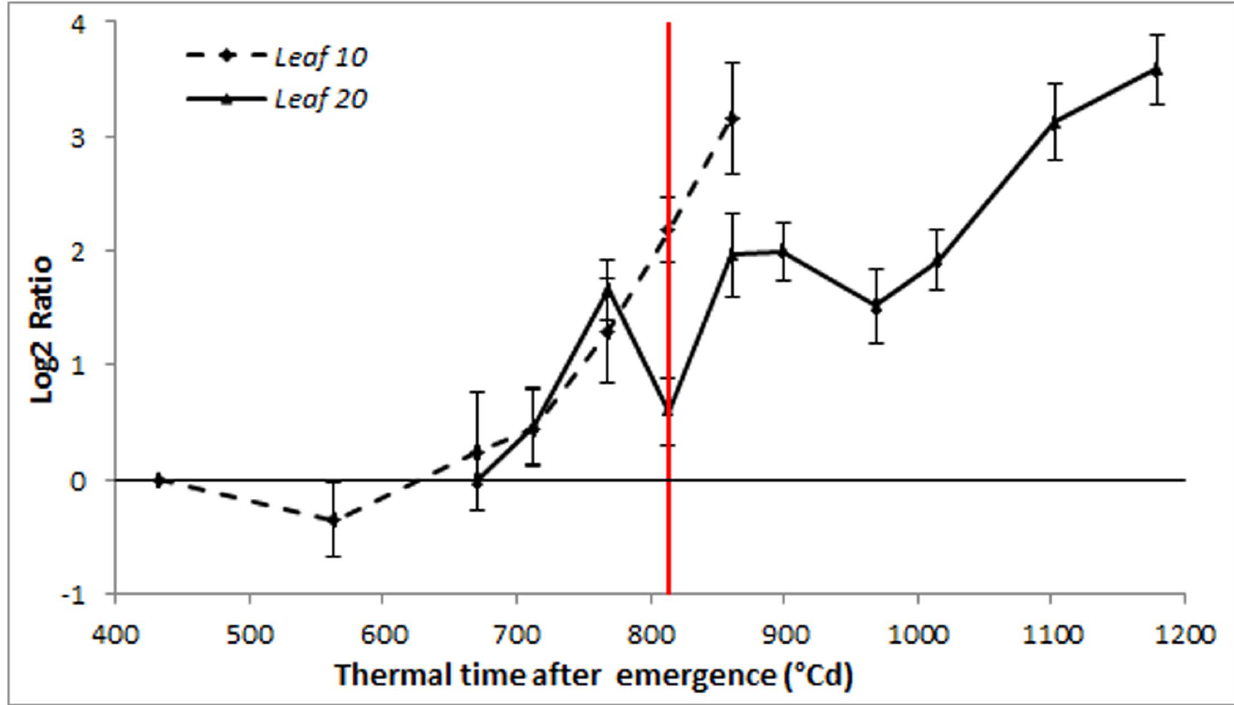
Figure 4. Ha-NAC01 expression profile. Relative Ha-NAC01 transcript level at each sampled point in relation to the level at the first sampling point determined by qPCR in leaf 10 and 20 ( Ha-EF1 a as RG). The red line indicates anthesis time. Error bars correspond to standard errors.